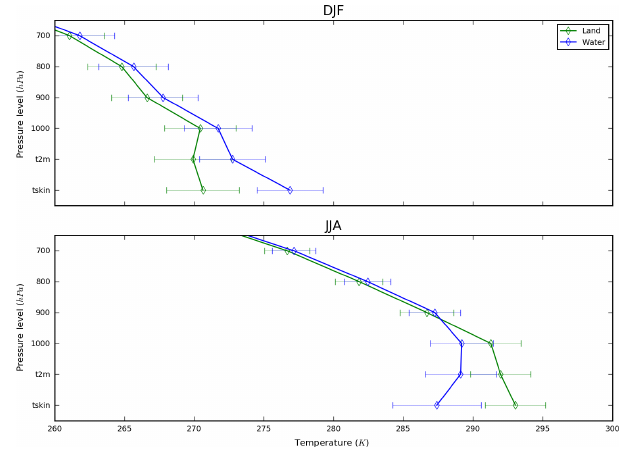
Figure 4. Mean temperature profile from ERA-Interim for the clos- est all-land and all-water model grid boxes to Halifax. Error bars show the standard deviation. Data are the mean of the 12:00 and 18:00UTC time steps (this corresponds to 08:00 and 14:00 local time, the closest ERA-Interim time steps to the local MOPITT over- pass time of ∼ 10:30) for